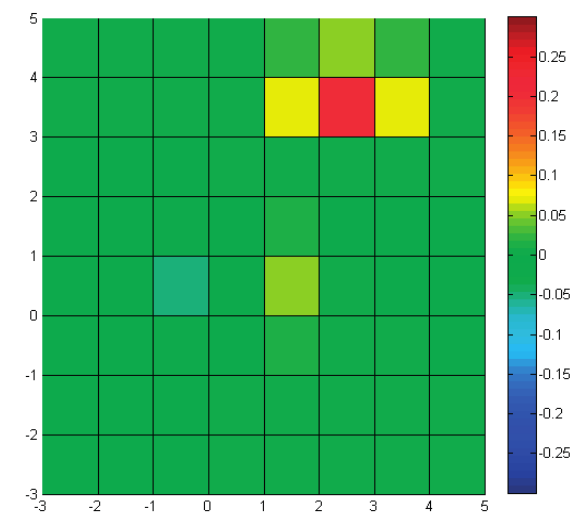
Figure 11. Measured model (initial): 2D plot with color